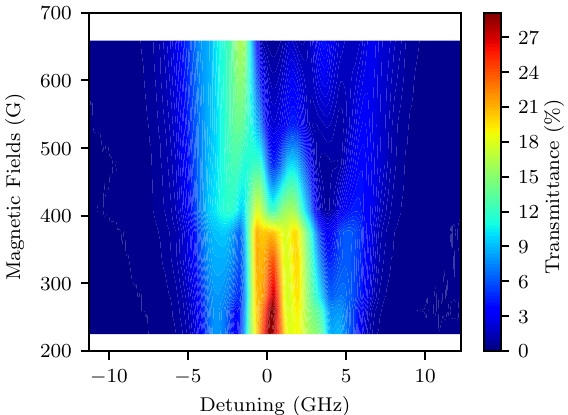
Figure 4. All the transmittance spectra for various magnetic fields and the discharge current of 18